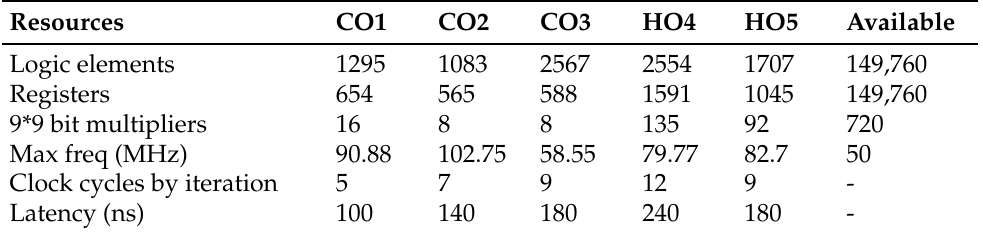
Figure 7. Block diagram description of Equation (6) for FPGA implementation applying AB6 highlighting function evaluation, integrator Adams–Bashforth, cumulative sum, finite-state machine (FSM) and RK4. Table 6. Hardware resources using FPGA Cyclone IV EP4CGX150DF31C7 and applying FE to CO1, CO2, CO3, HO4 and